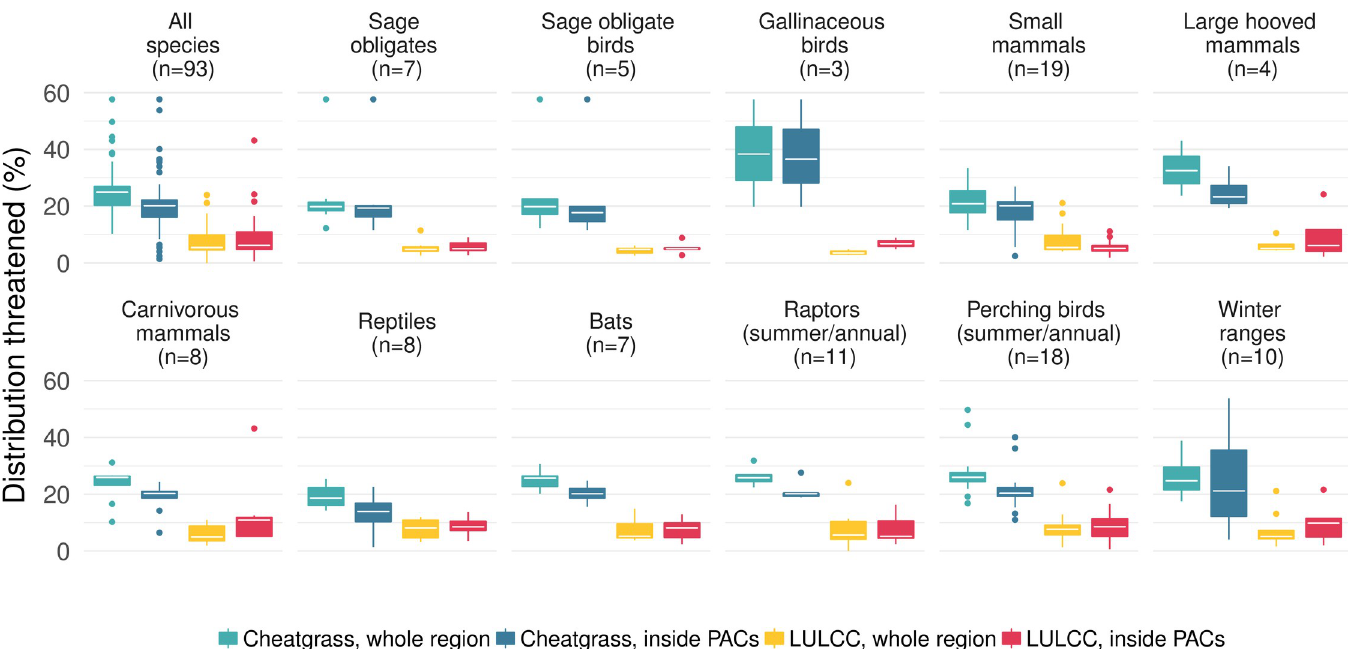
Fig 4. Proportion of 83 sagebrush-associated species (including sage grouse) ranges that are threatened by land use or land cover change (LULCC—urbanization, cropland conversion or forest expansion) by 2050 or by cheatgrass invasion. The proportion threatened across the whole study region (teal, yellow), including protected areas, is compared with that threatened within Priority Areas for Sage Grouse Conservation (PACs–blue, red). The cross-species median area threatened is shown by a white